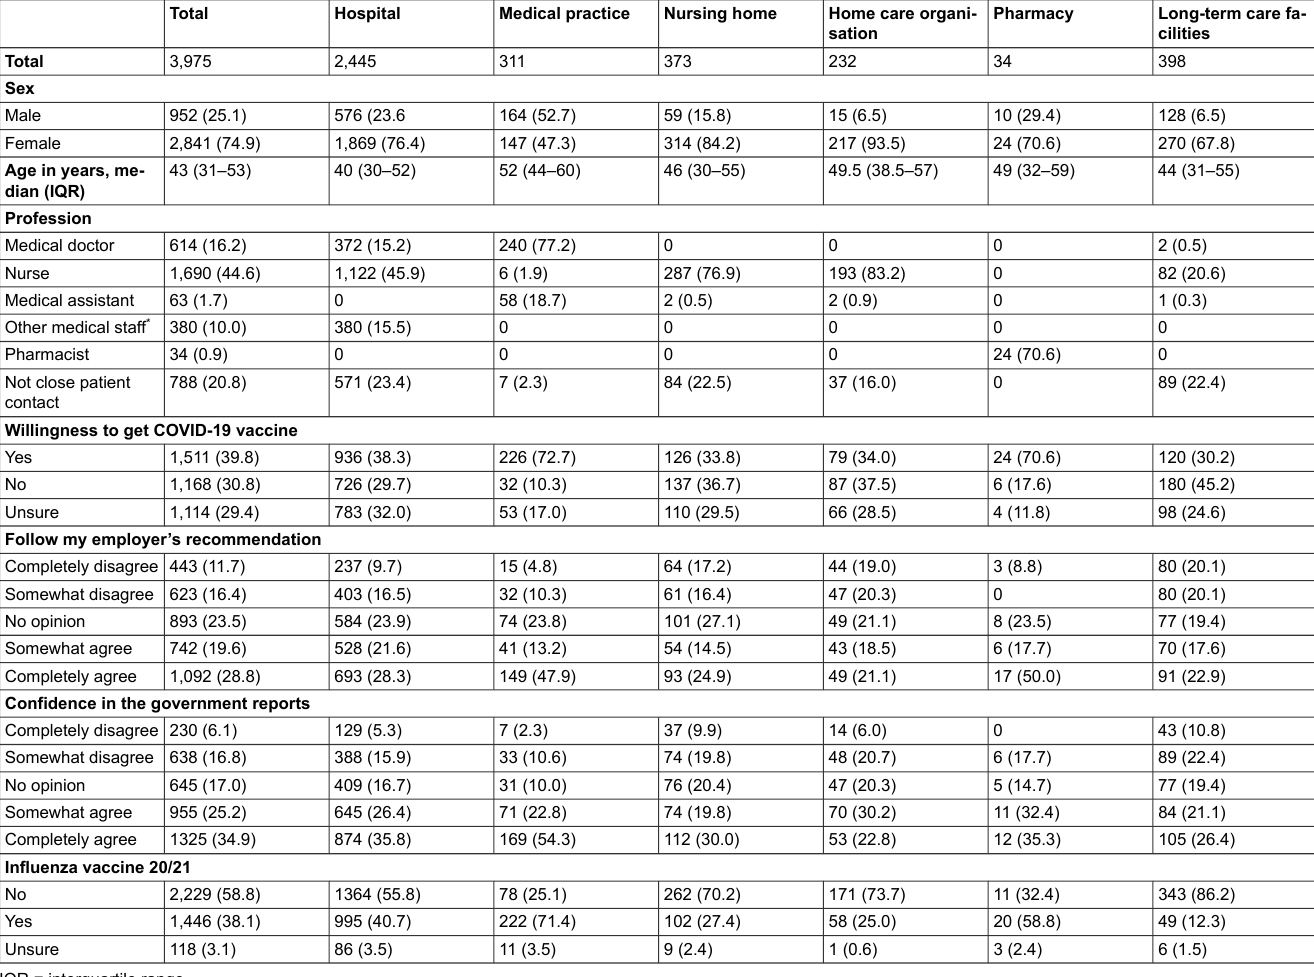
Table S2: Participant characteristics by workplace. Total